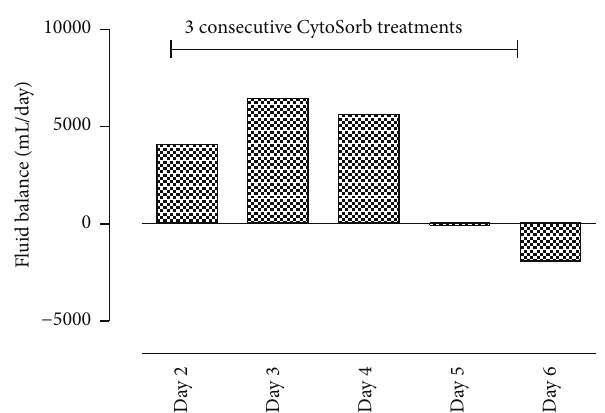
Figure 4: Fluid balance during the three consecutive CytoSorb